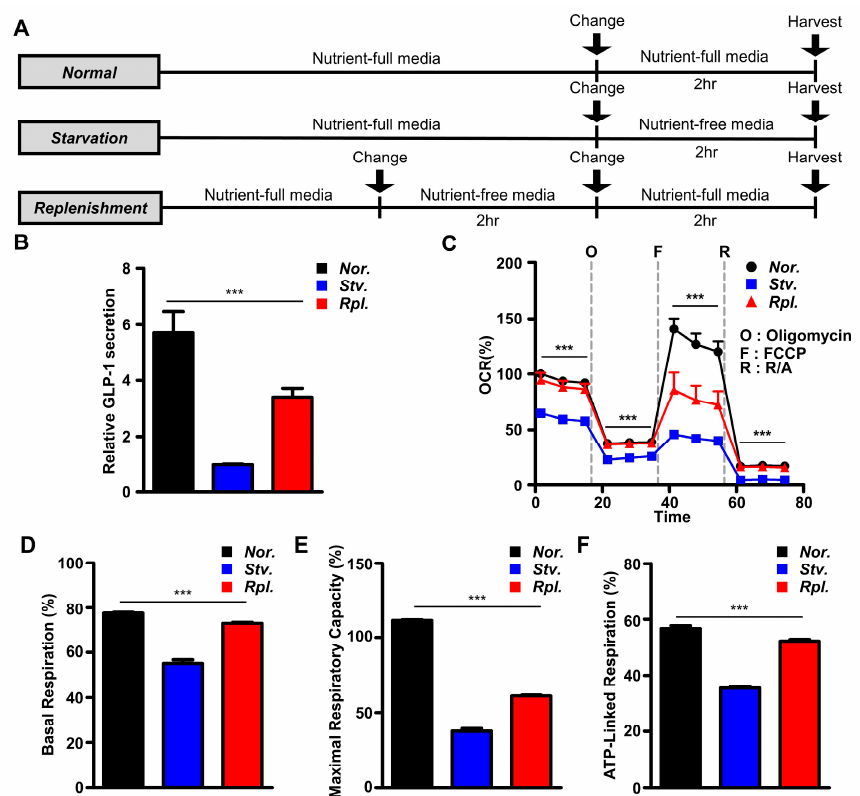
Figure 1. Nutritional stress rapidly controls glucagon-like peptide-1 (GLP-1) secretion and cellular bioenergetics in GLUTag cells. ( A ) Experimental scheme for in vitro studies. ( B ) Level of GLP-1 secretion in response to di ff erent nutritional status. All data were analyzed by GLP-1 ELISA ( n = 9). ( C ) Cell respiration of oxygen consumption rate (OCR) in vitro ( n = 3–6). ( D ) Basal respiration ( n = 3–6). ( E ) Maximal respiratory capacity ( n = 3–6). ( F ) ATP-linked respiration calculated from OCR ( n = 3–6). Data represent the mean ± SEM. *** p < 0.001; one-way